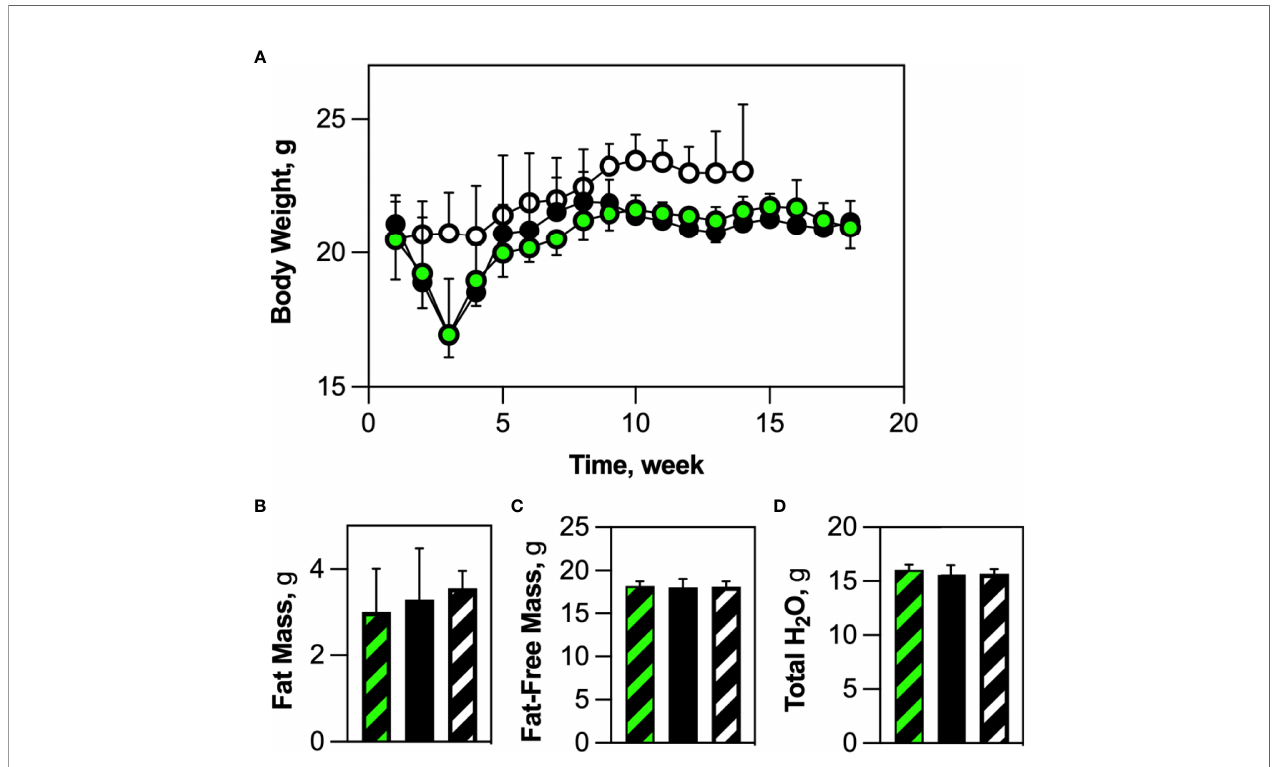
FIGURE 4 | HSCDA depletion did not elicit changes in body weight or composition. (A) Wild-type mice were transplanted with HSCs from either AdipoQ or AdipoQ DTA donor mice to generate Competent (black/green circles) or Ablated (black circles) cohorts, respectively. Transplant-naive control mice are indicated by black/ white circles. After transplant, mice in all cohorts were weighed weekly. (n=10 per cohort) (B – D) 18 weeks (2 weeks recovery + 16 weeks experimental) after transplantation, transplant-naïve, (white/black crosshatch bar), Competent (black/green crosshatch bar) and Ablated (solid black bar) mice were subjected to quantitative magnetic resonance analysis to measure body composition. No changes in percent fat mass, fat-free mass or total water content were observed. (n=8 per